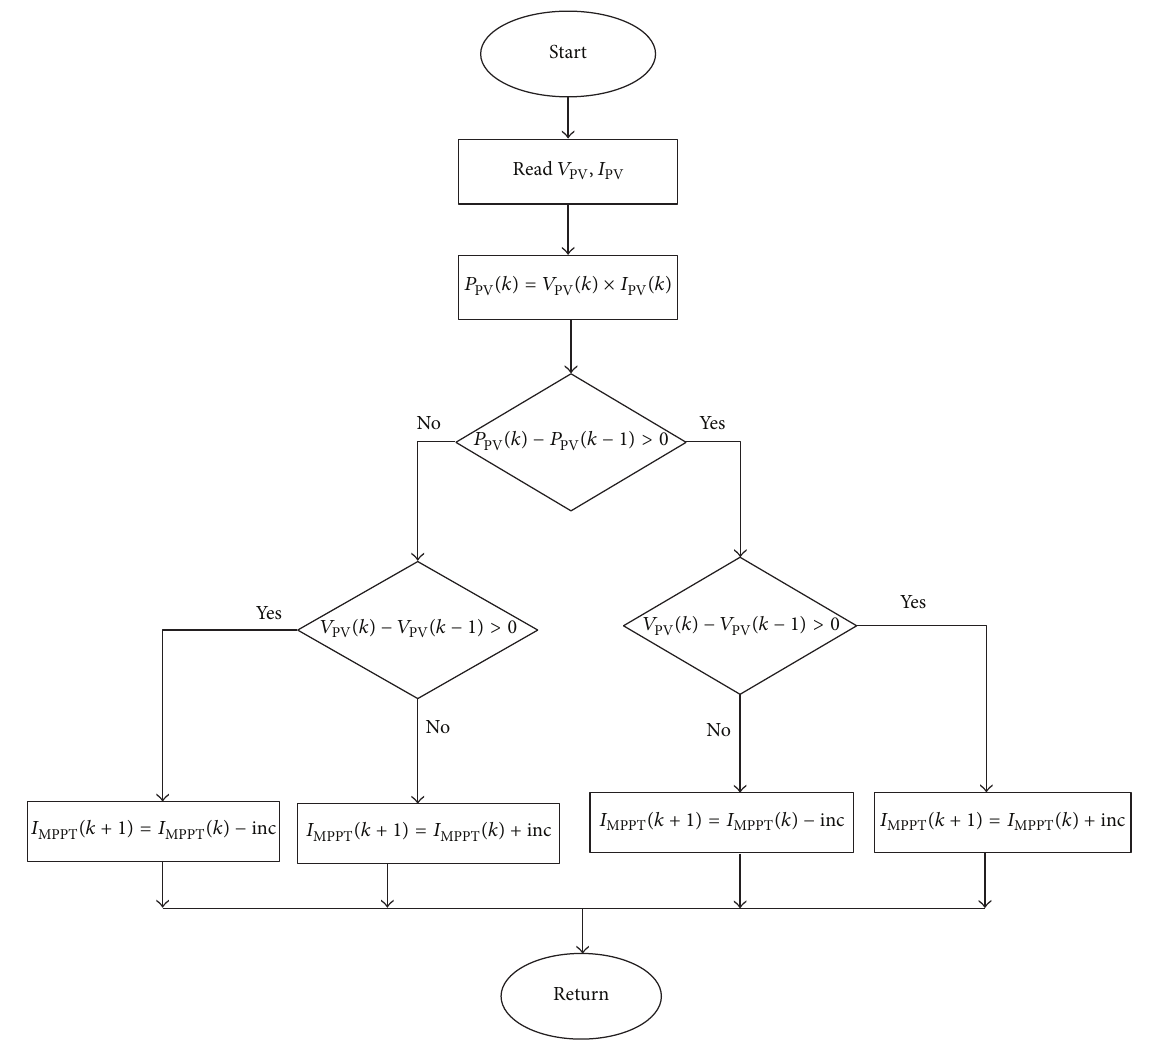
Figure 4: Flowchart of perturbation and